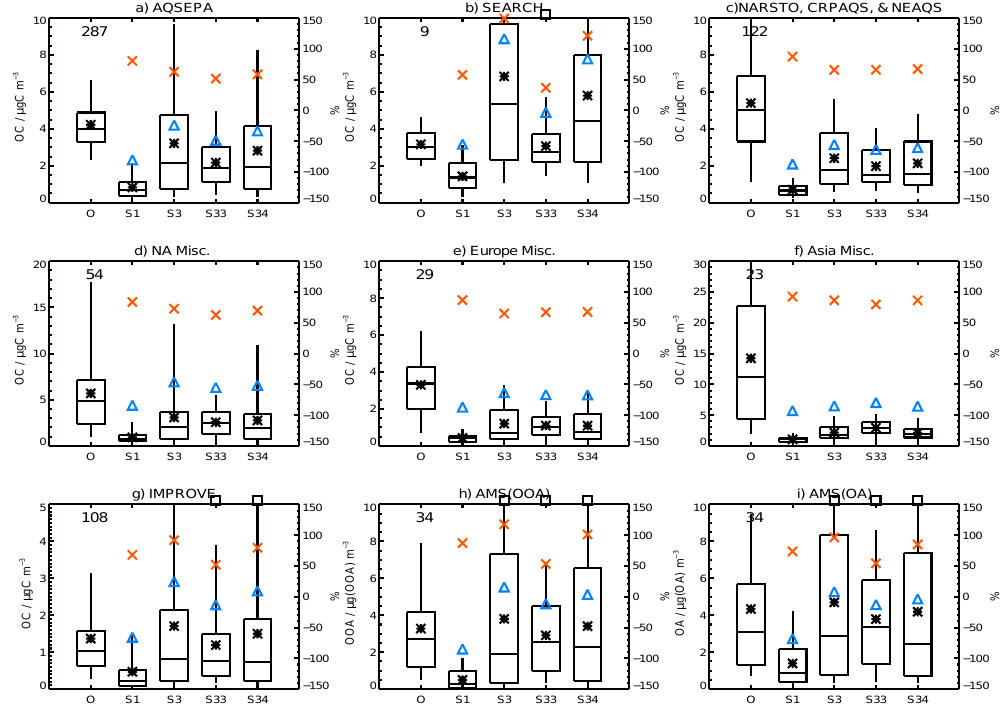
Fig. 9. Box and whisker plots showing observed (O) and simulated (S) monthly mean organic carbon (OC) aerosol. Panels (a) through (g) are OC concentrations from Bahadur et al. (2009) (see Sect. 2.4 for details). Observations from the AMS are shown in panels (h) OOA and (i) OA. The number of separate locations is reported in each panel. Four different model simulations are shown (Table 1) S1: standard model (monoterpene SOA: 32.3Tg(SOA)a − 1 ); S3: enhanced biogenic SOA (monoterpene SOA: 246.0Tg(SOA)a − 1 ); S33: our best estimate SOA sources (monoterpene: 6.5Tg(SOA)a − 1 , isoprene: 6.5Tg(SOA)a − 1 , biomass burning: 3Tg(SOA)a − 1 , POA to SOA ageing: 23Tg(SOA)a − 1 , anthropogenic controlled SOA: 100Tg(SOA)a − 1 ); S34 best estimate sources but with restricted anthropogenic SOA (as S33 but anthropogenic controlled SOA: 10Tg(SOA)a − 1 , monoterpene SOA: 195Tg(SOA)a − 1 ). The average of the monthly means is shown by the star and the median of the monthly means as a horzontal line. The boxes show 25th and 75th percentiles, whiskers the 5th and 95th percentiles. The normalised mean bias (blue triangle) and normalised mean error (red cross) between model and observations are plotted against the right hand axis. Open squares above model simulations denote where the model is not significantly different from the observations at the 99% level ( p < 0 .